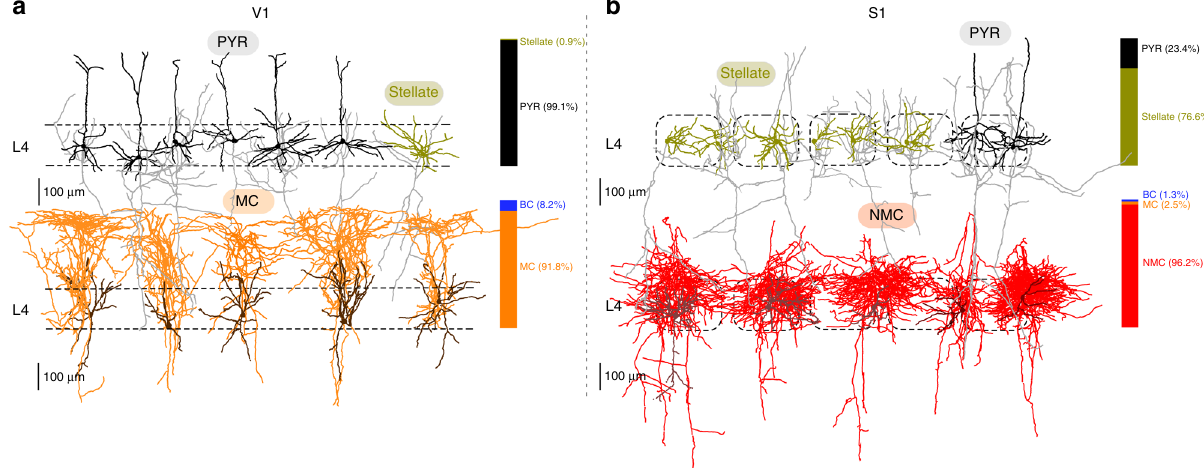
Fig. 3 V1 differs from S1 in excitatory cells and SOM + interneurons in L4. a Representative morphologies of excitatory and SOM + neurons in V1 L4. Bar graphs indicate the fractions of each cell type among all morphologically recovered excitatory neurons (top) and all morphologically recovered neurons labeled in the SOM-Cre line (bottom). b The same in S1 L4. Dashed rectangles represent individual cortical